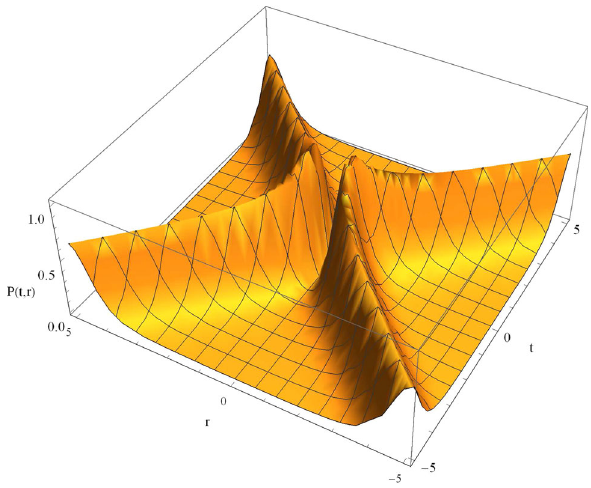
Fig. 2 | (cid:4) | 2 of original Hajicek–Kiefer paper (Eq. (18)) for λ = κ =